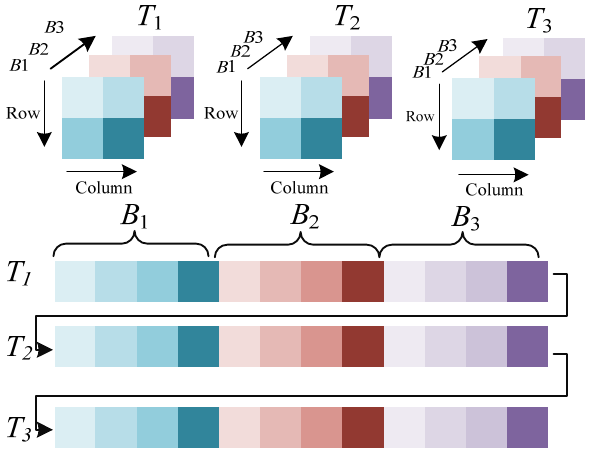
Figure 3. TSB storage structure (T and B represent time and bands of the images, respectively).